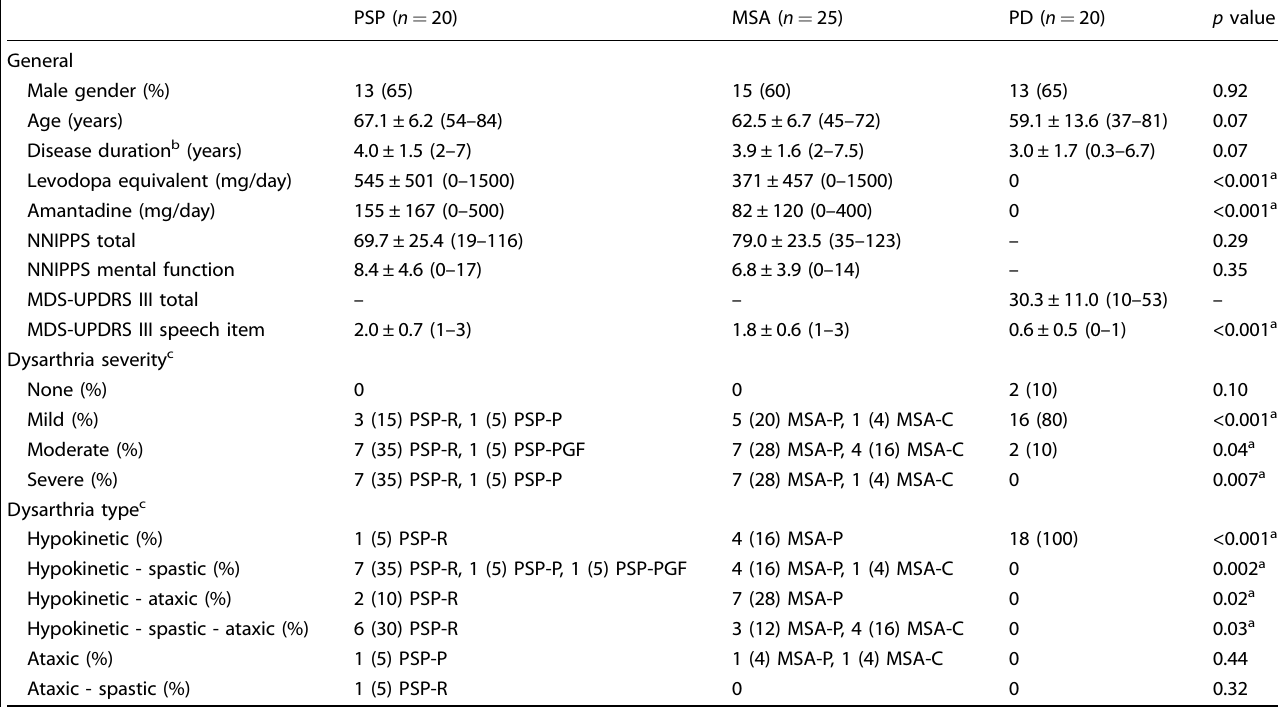
Table 6. Patient clinical and demographic